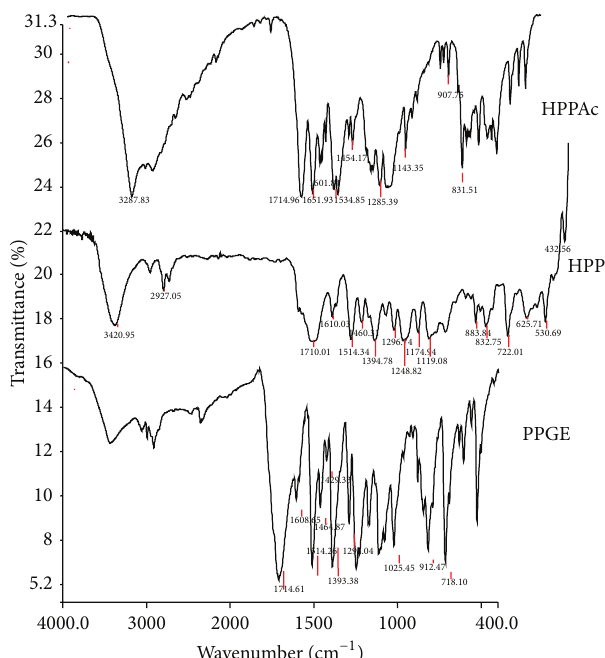
Figure 1: FT-IR spectra of HPPAc, HPP, and